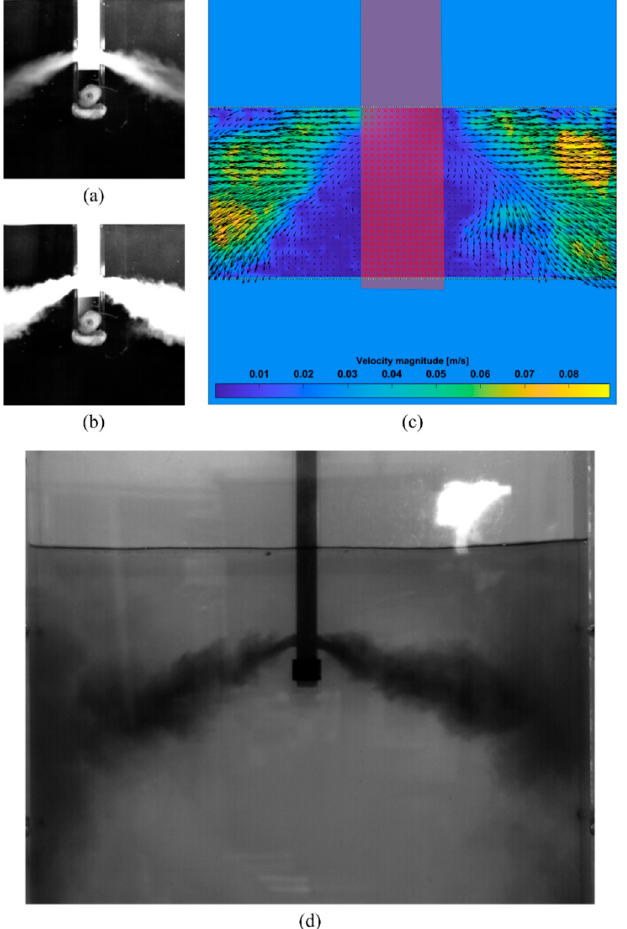
Figure 9. Visualization of the hydrodynamic behavior inside the mold by using ink injections. Panels ( a , b ) show the initial stages of ink entry into the mold for the type A NIP. Panel ( c ) shows the estimated velocity vector field for the test presented in panels ( a , b ). Panel ( d ) shows the entire shape of the jets emerging from the type A NIP.